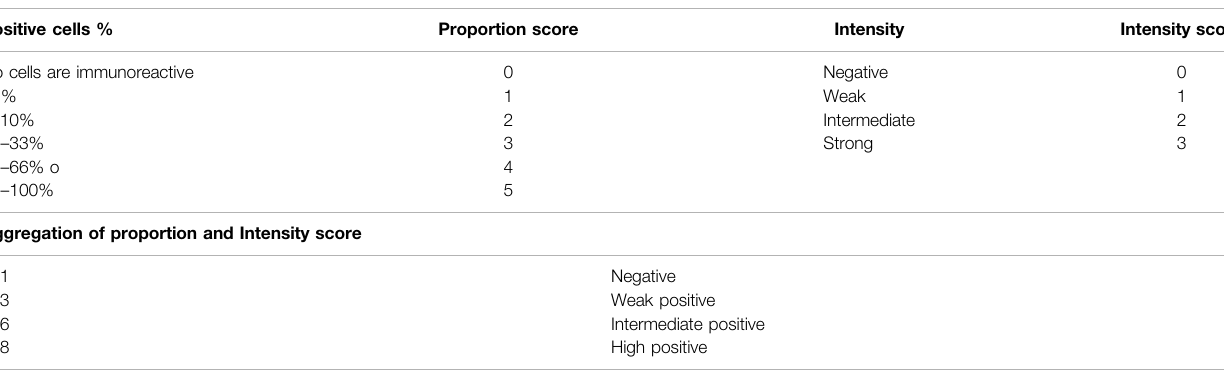
TABLE 2 | The Allred score combined intensity and percent of immunoreactive